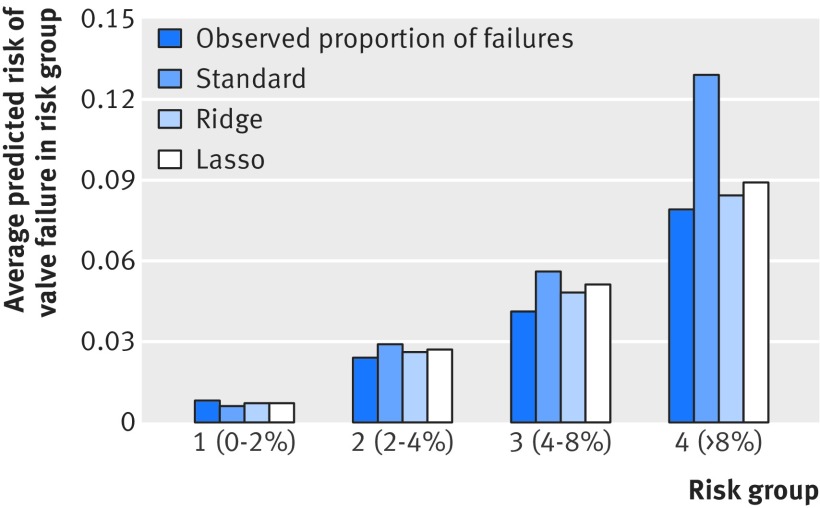
Fig 2 Observed proportions versus average predicted risk of the event (using standard, ridge and lasso regression). Overestimation of risk for high risk patients can be seen when standard regression is used